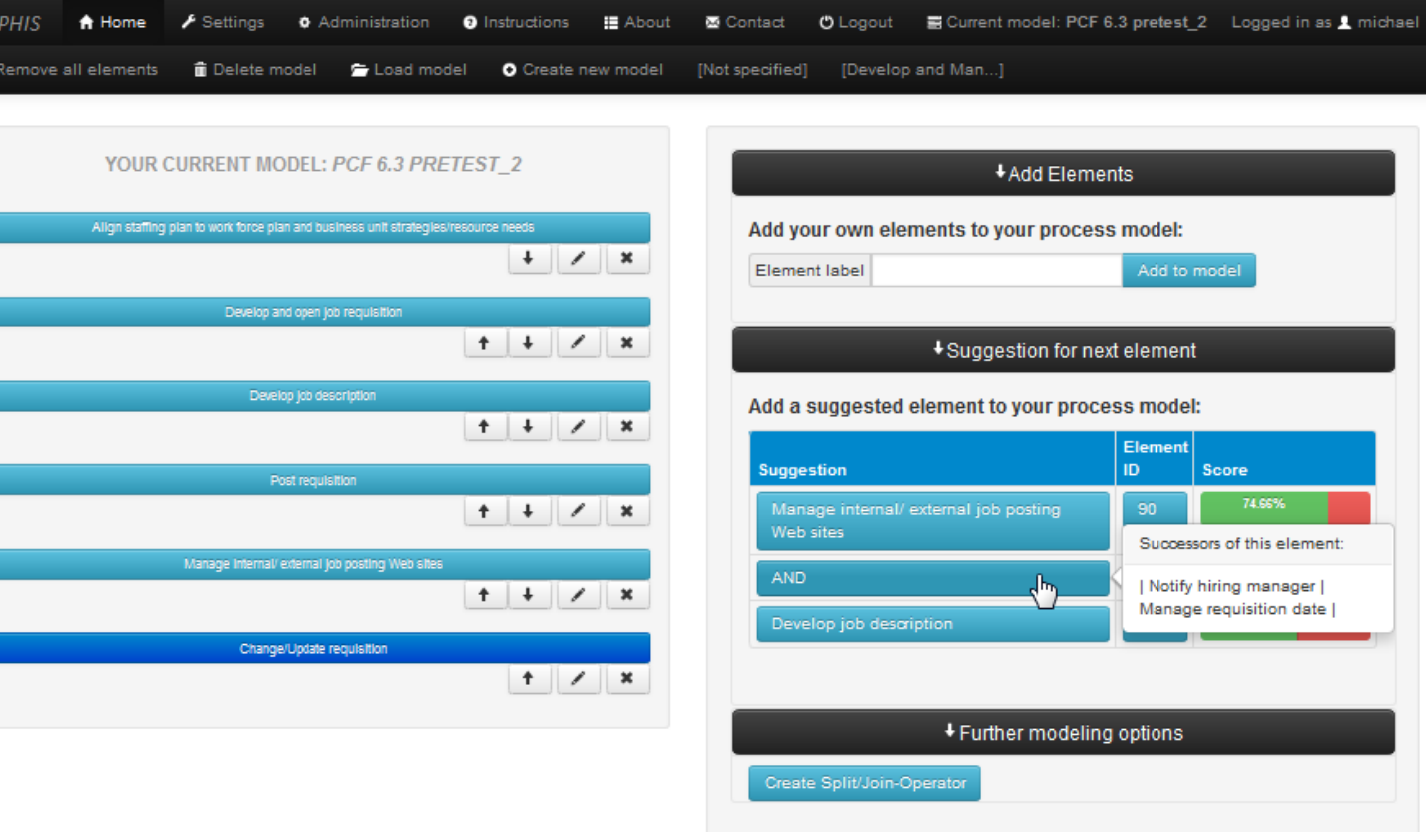
69 Figure 2. Web-based recommender demo for business process